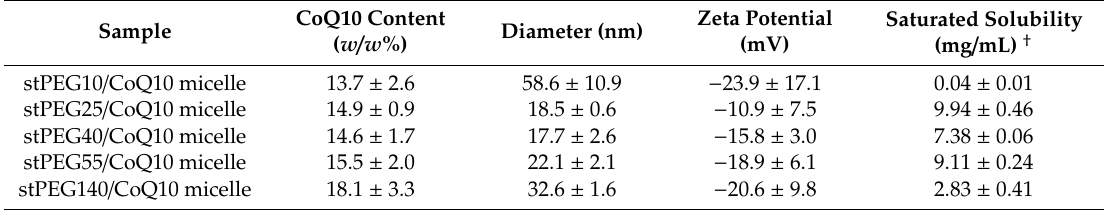
Table 2. Properties of the stPEG / CoQ10 micelles.